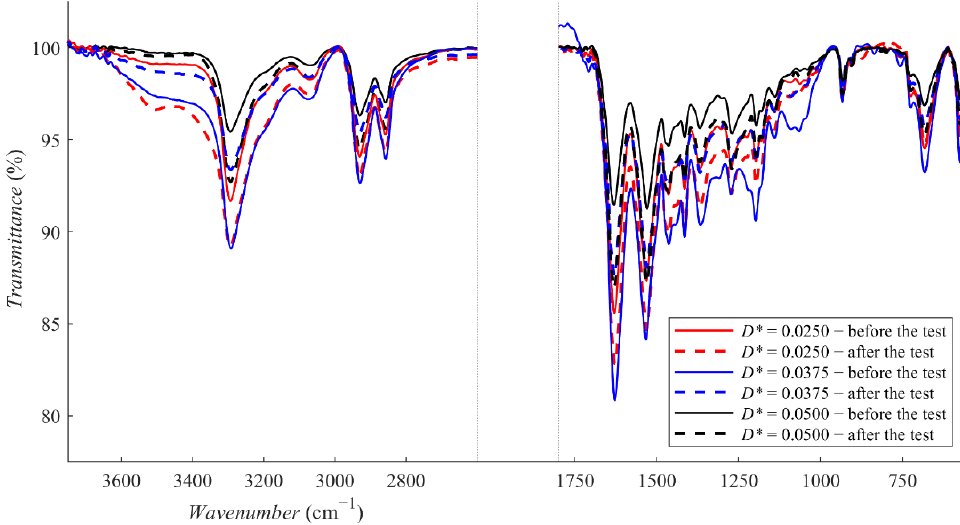
Figure 4. FTIR spectra of nylon fibers prior to and after the runs.